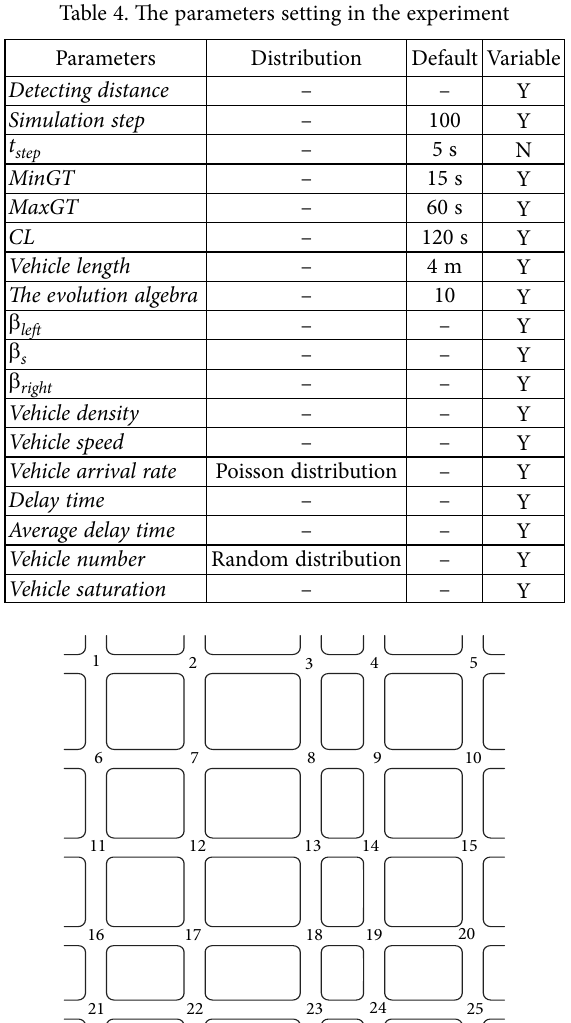
Fig. 4. Local traffic network